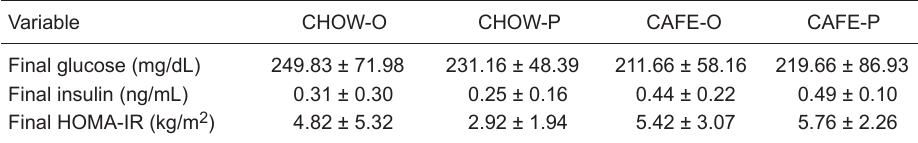
Table 1. Blood glucose, insulin, and HOMA-IR in the chow-only group (CHOW-O), chow-pioglitazone group (CHOW-P), cafeteria-only group (CAFE-O), and cafeteria-pioglitazone group (CAFE-P). Variable